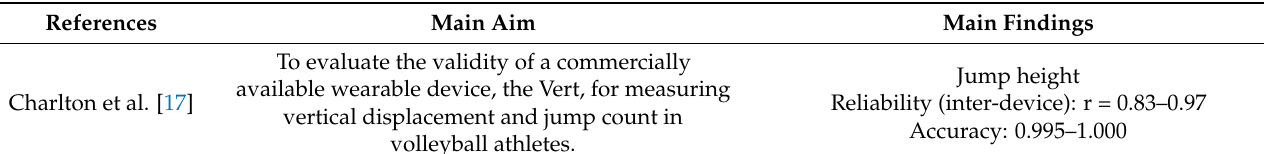
Table 3. Analysis of the main results of the studies included in the